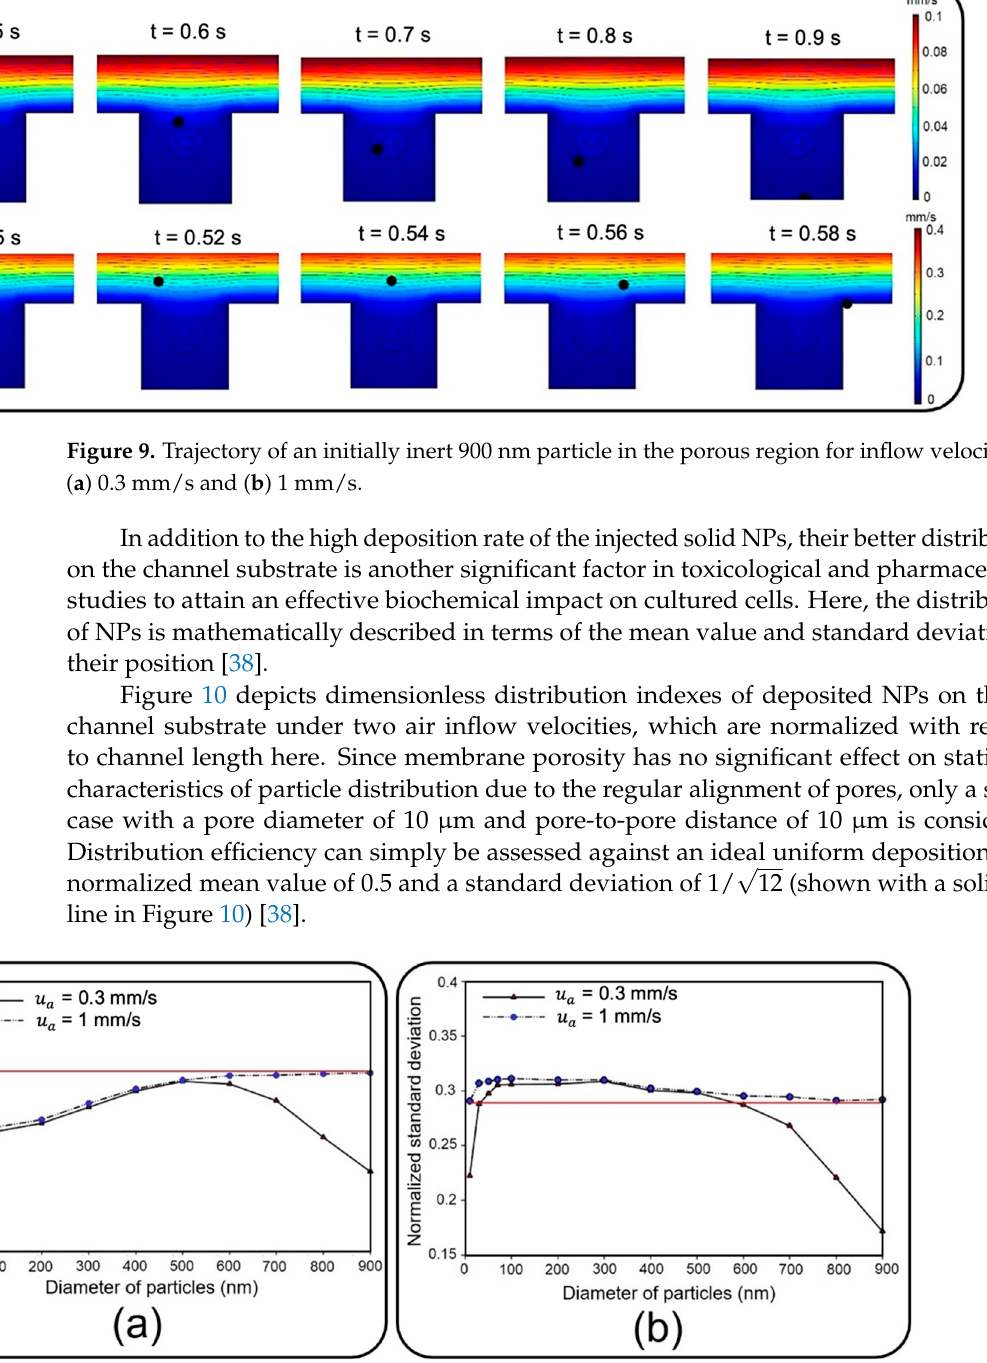
Figure 11. Snapshots from transient distribution of NPs with a diameter of 900 nm in the lung-on- a-chip device with pore diameter and pore-to-pore distance of 10 µm under the fluid velocity of ( a ) 0.3 mm/s, and ( b ) 1 mm/s. 4.2. Translocation of Nanoparticles This section deals with the translocation of airborne NPs into the media channel of the lung-on-a-chip device, mainly analyzing transfer rate and distribution efficiency. Fig- ure 12 compares the transfer rate of NPs for different membrane porosities and inflow velocities. A higher translocation efficiency seems achievable by increasing the former and decreasing the latter. The obtained results show that for constant membrane porosity and inlet velocity, the transfer rate declines by increasing the particle diameter up to 200 nm, whereafter it starts to go up. Higher transfer rates arise from Brownian diffusivity for small particles and dominancy of gravity force, as well as longer residence time in the porous regions for large particles.